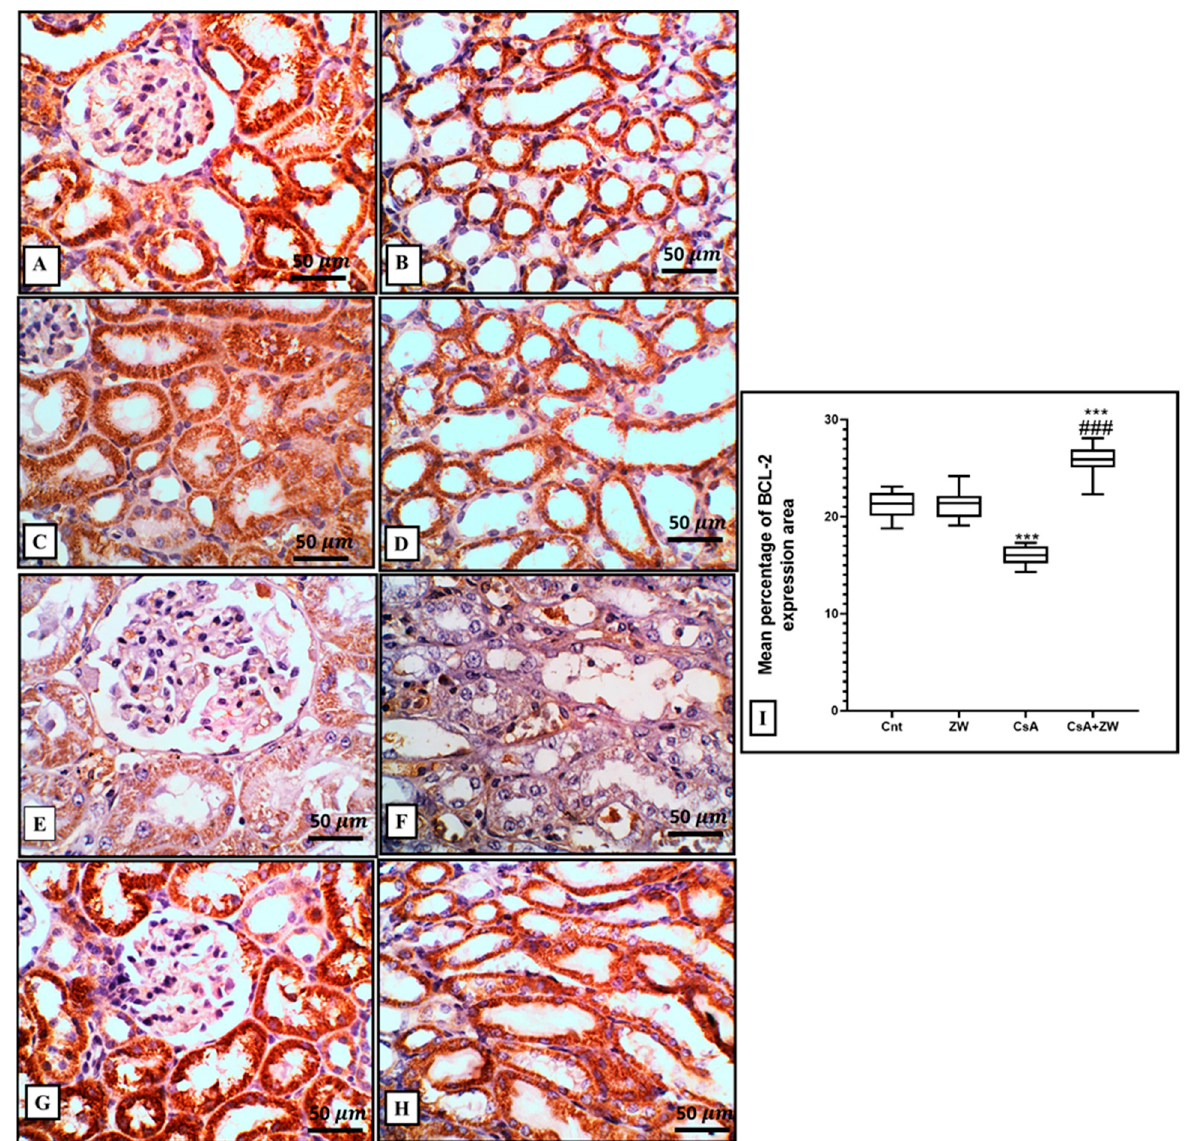
Figure 6. Representative Bcl2-immunohistochemistry of the kidney. ( A – D ) The control and ZW groups show di ff use strong expression in the normal cortical and medullary tubular epithelium. ( E , F ) The CsA group shows di ff use moderate expression in necrotic, sloughed tubular cells and in the cytoplasm of vacuolated and intraluminal cells. ( G , H ) The CsA + ZW group shows di ff use strong Bcl-2 expression in the cortical and medullary tubules. ( I ) Histogram of the percentage area of immunostaining of renal Bcl-2, *** p < 0.001 vs. control; ### p < 0.001 vs. CsA. Image magni fi cation = 400×; bar = 50 µm.